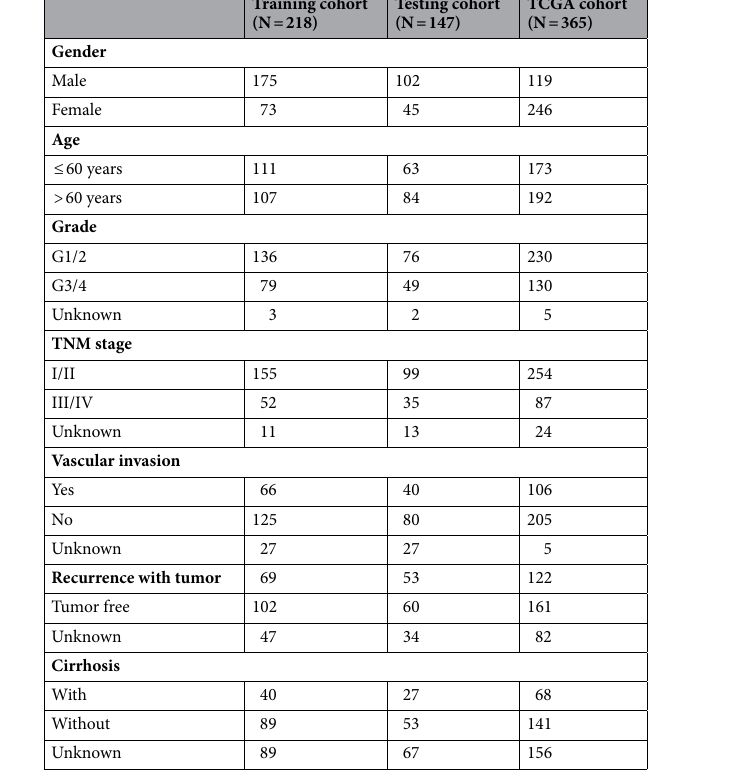
Table 1. Clinical characteristics of HCC patients involved in the